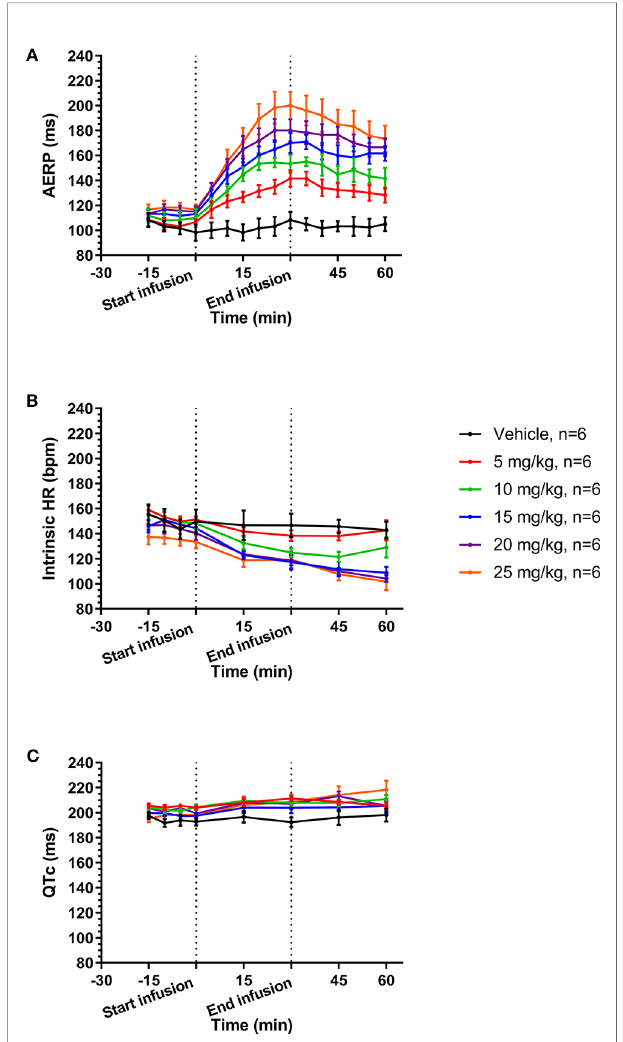
FIGURE 4 | Average values before, during, and after infusion of increasing concentrations of AP30663 of atrial effective refractory period (AERP) (A) , intrinsic heart rates (B) , and QTc (C)